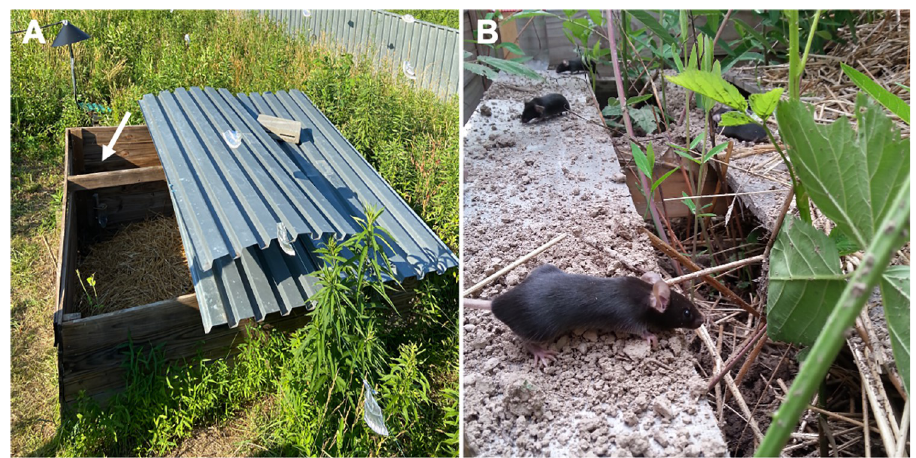
Fig 1. Free-range laboratory mice. ( A ) A close-up view of a wedge in the Stony Ford outdoor enclosure facility. Individual wedges contain 2 watering stations and a feeding station (yellow star) supplied with the same mouse chow that laboratory mice receive in the institutional vivarium. ( B ) During the process of rewilding, adult C57BL/6J mice raised in a specific pathogen-free (SPF) facility are introduced into the enclosure where they are exposed to fungi in the environment as they explore their surroundings. Photo courtesy of Christina B . Hansen and Andrea Graham , Princeton University .